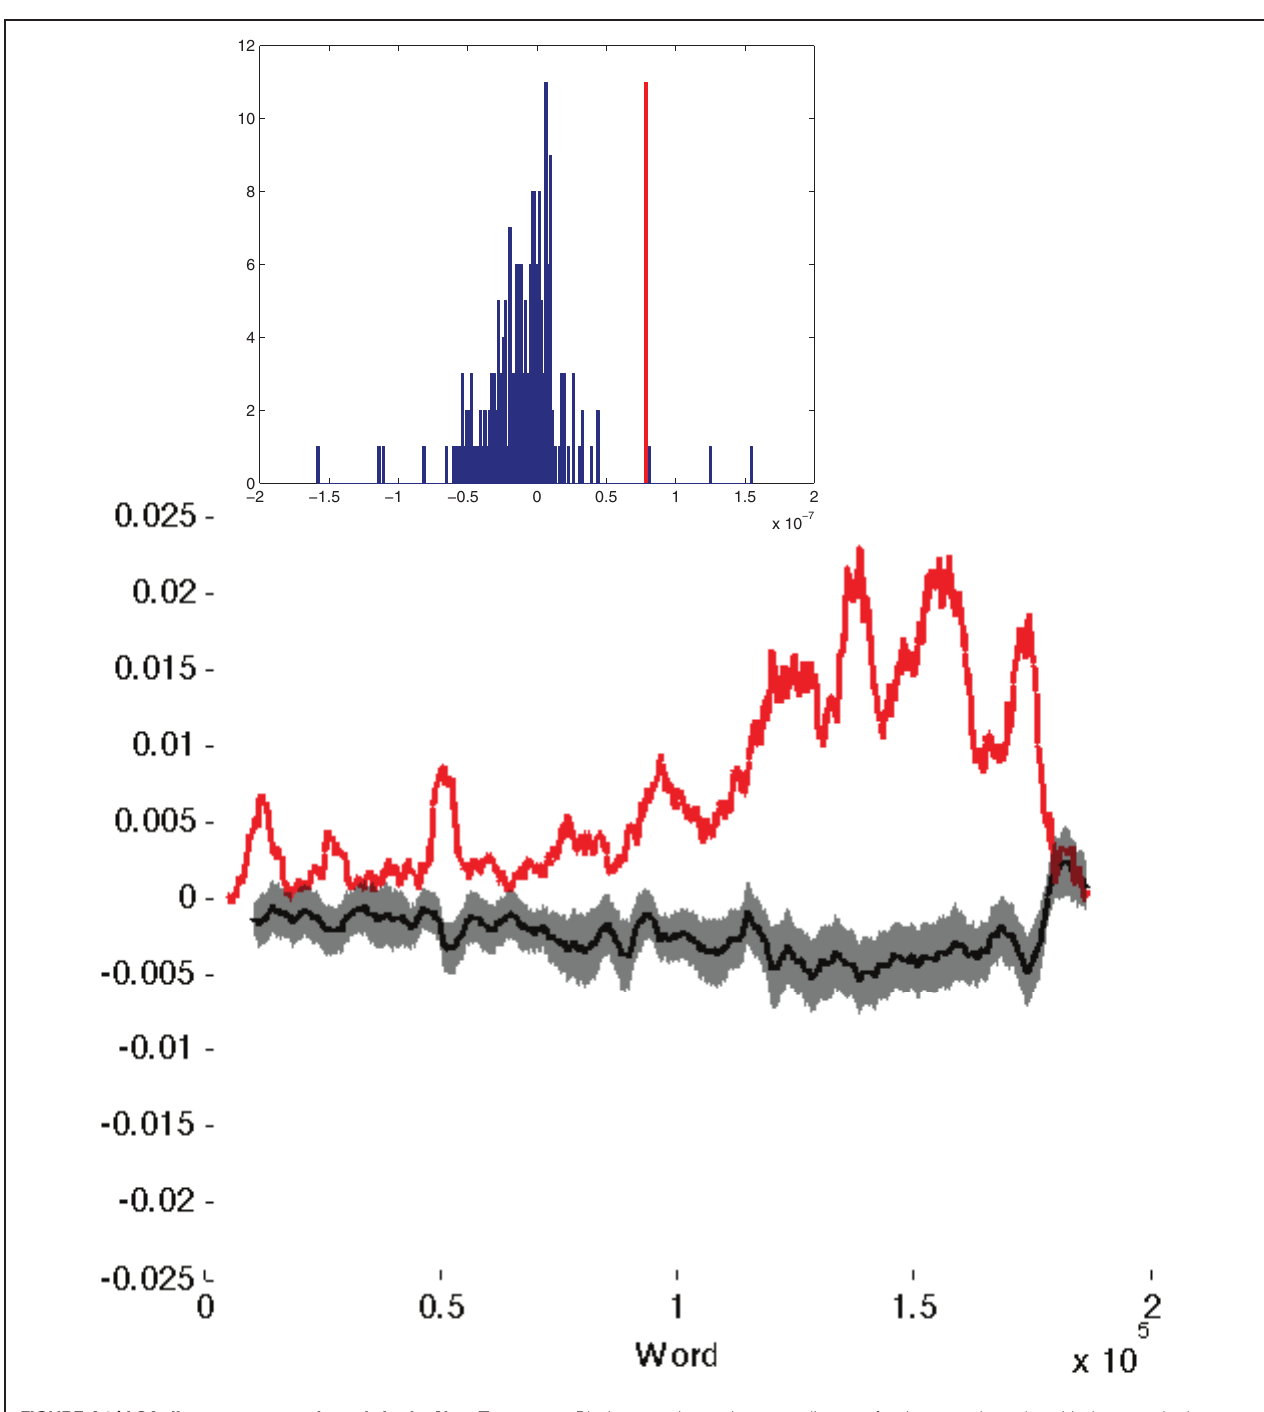
FIGURE A4 | LSA distance to control words in the New Testament. Black curve shows the mean distance for the control words, with the gray shadow indicating standard deviation. The red curve corresponds to introspection.